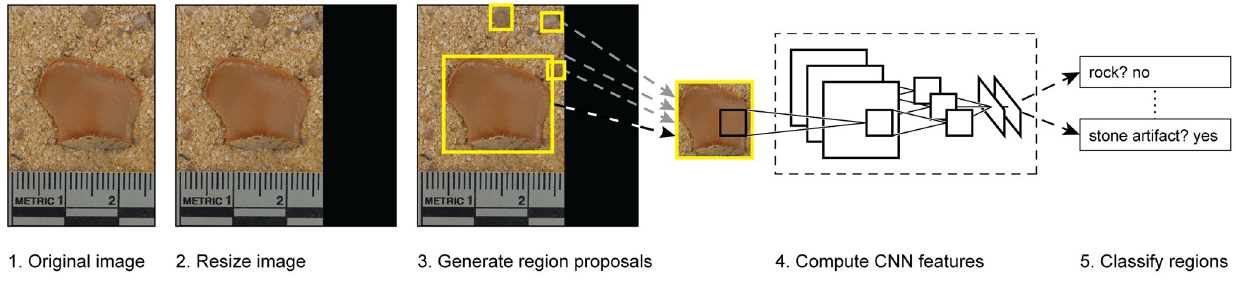
Fig 2. Example of a convolution neural network (CNN)